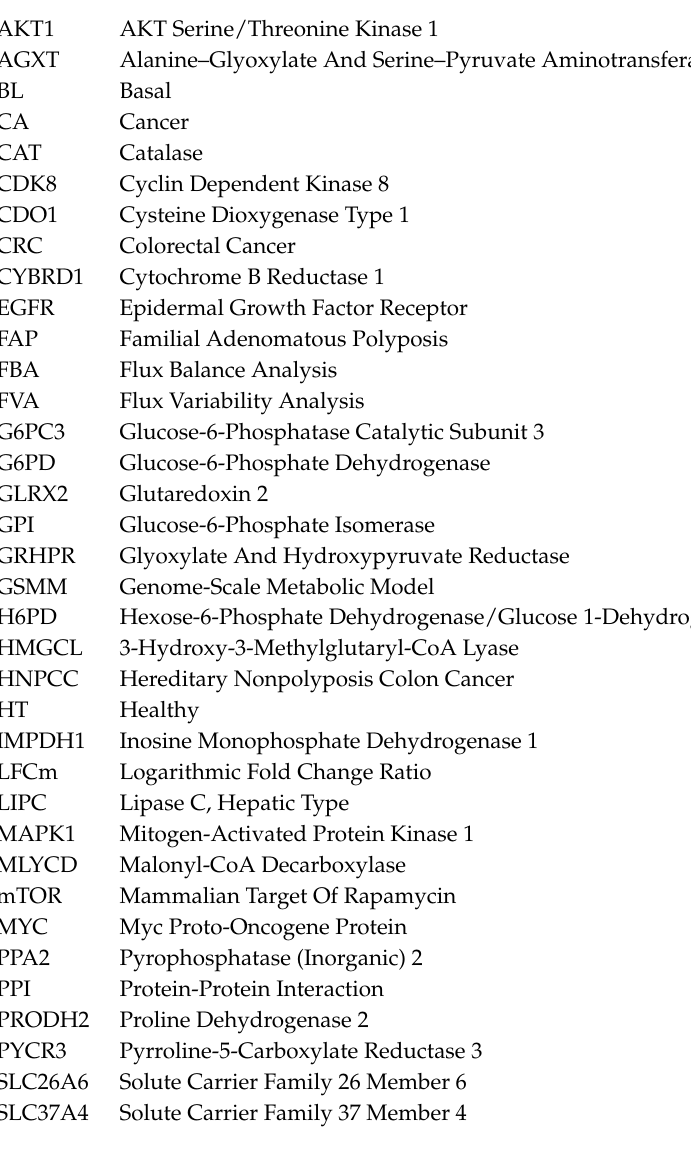
Figure S1: A numerical example to illustrate the computation of template, similarity ratio, and LFC, Figure S2: Flowchart of the NHDE algorithm for solving the TLOP, Figure S3: Definition of triangular membership function of fitness, Figure S4: Categories of flux variance between the normal and mutant model, Figure S5: Average similarity ratios computed by FVA, Table S1: Nutrients from RPMI-1640 and DMEM medium, Table S2: Genes associated to FAP and HNPCC from GeneCards database, Table S3: Average change ratios (CR) and similarity ratios (SR) of oncogenes in different